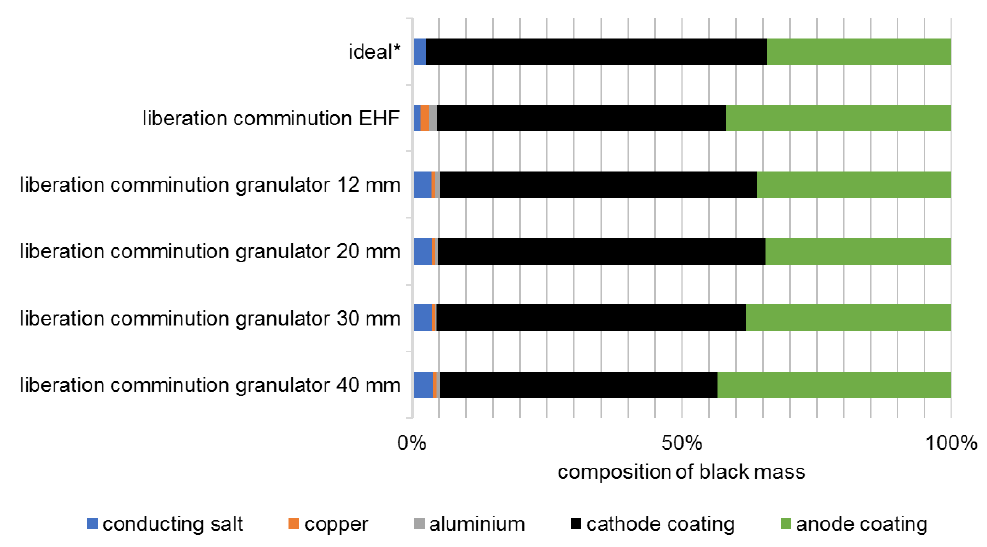
Figure 8. Composition of the black masses of cell type 1 after liberation (ideal: composition of the coating materials in the intact battery cell). * Conducting salt content estimated according to [16].